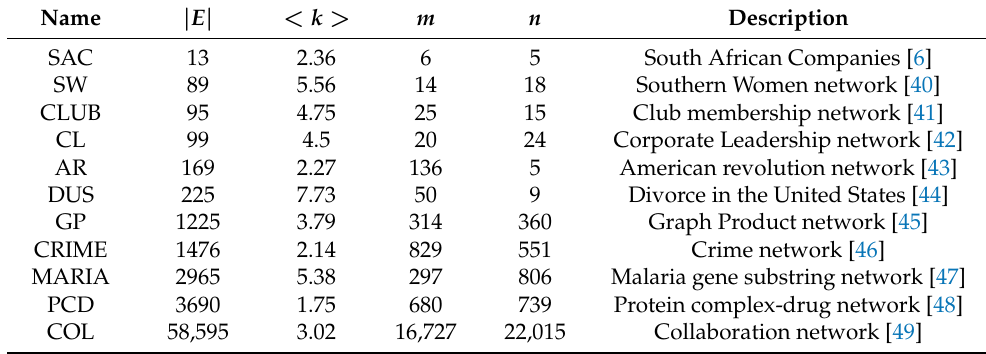
Table 4. Details of 11 real-world